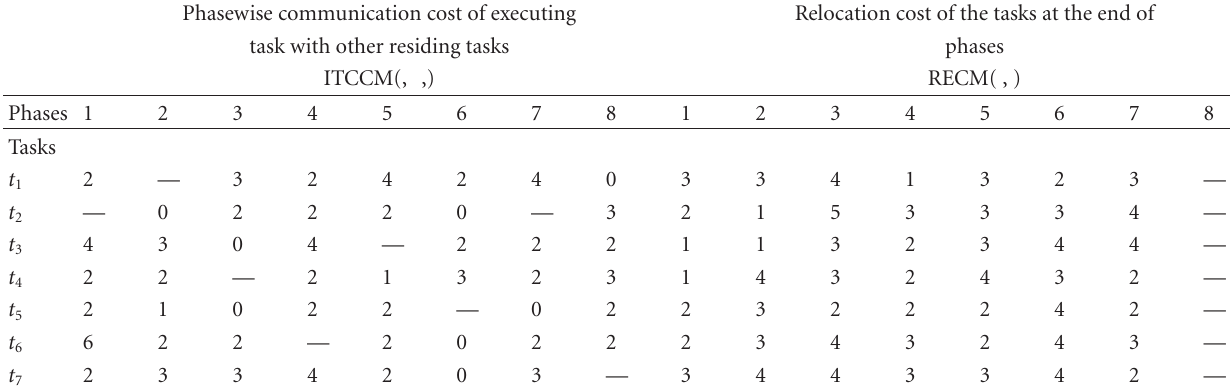
Table 4: ITCCM(, ,) and RECM( ,